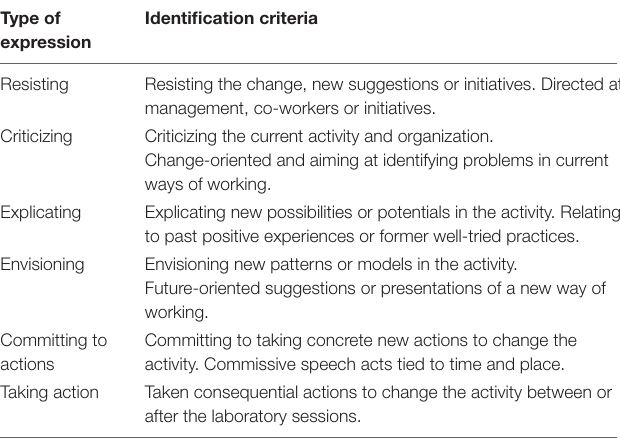
TABLE 2 | Six types of the expressions of transformative agency. Type of Identification criteria expression